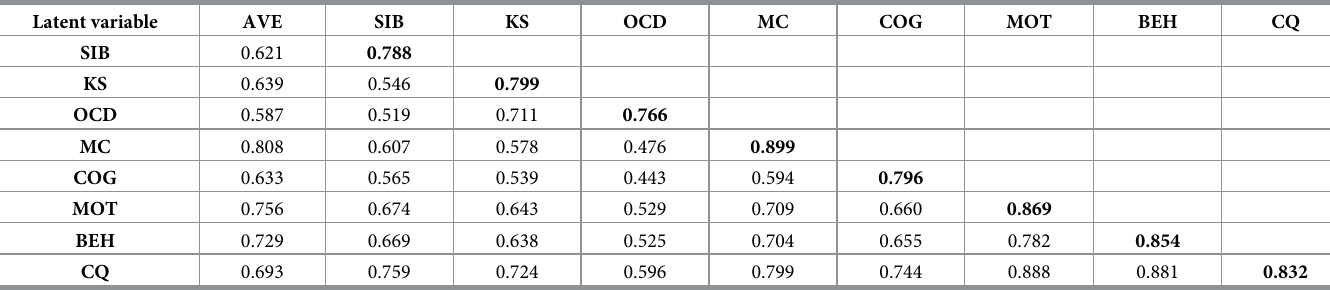
Table 3. Differential